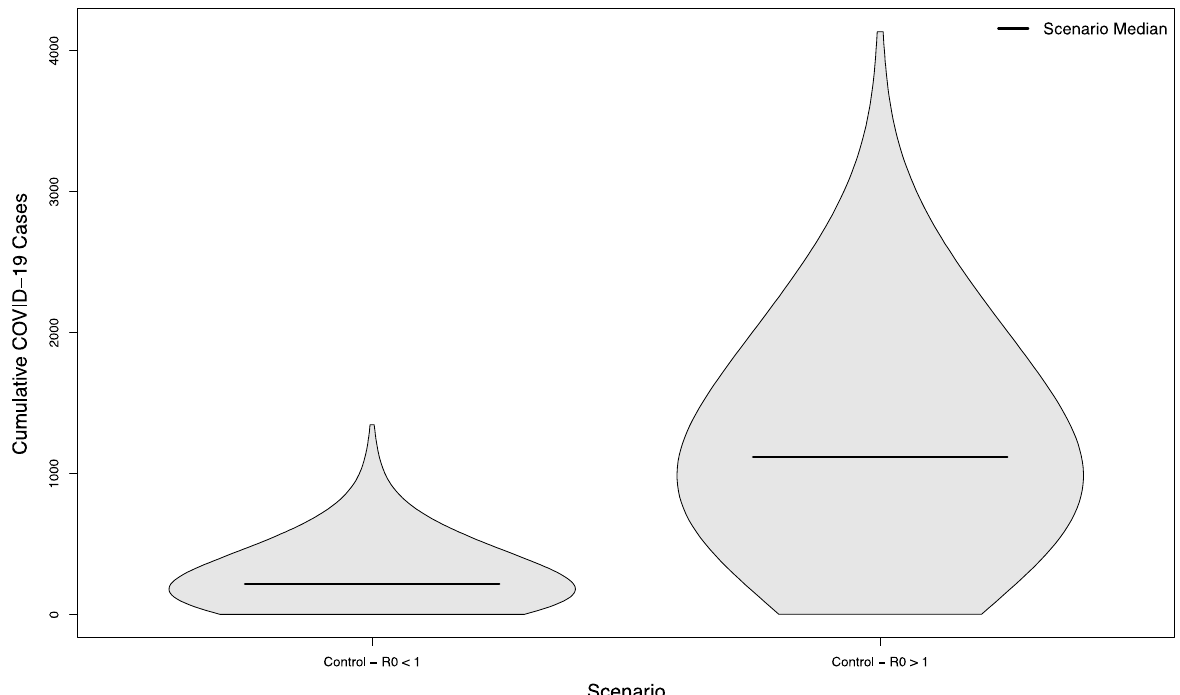
Figure 2. Distribution of cumulative COVID-19 cases in 1000 simulated university campuses with no in-person sporting events, with and without control of their respective epidemics.